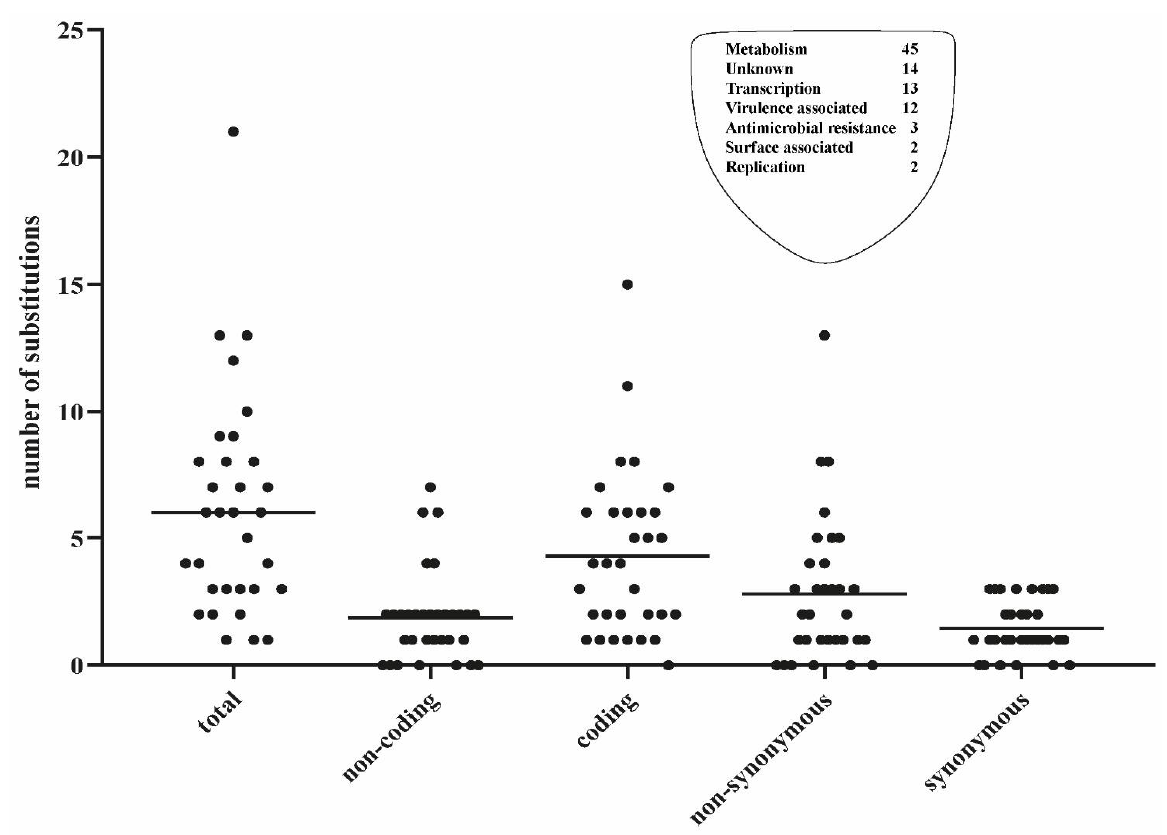
Figure 1. Number of SNPs between the first and recurrent infection in 32 matching UTI pairs and the number of non-synonymous SNPs divided into categories based on annotations. Lines illustrate medians.